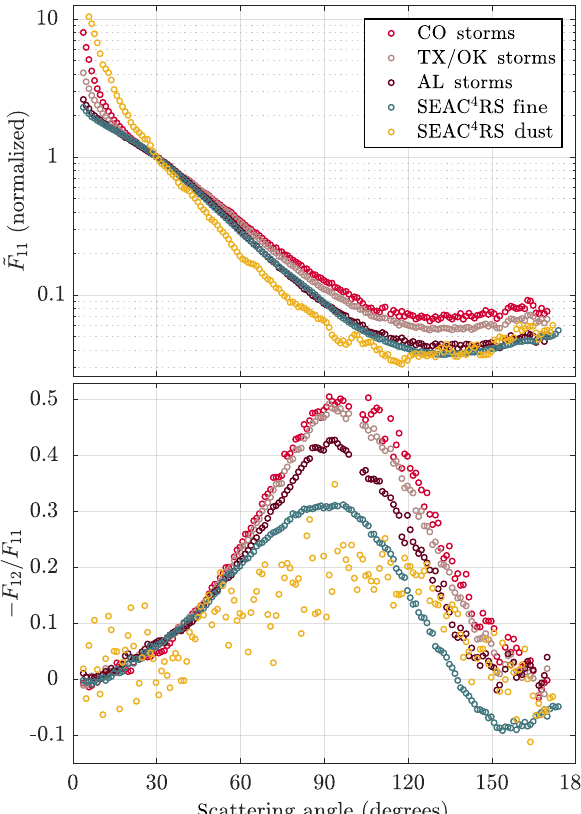
Figure 3. Average 532nm e F 11 and − F 12 /F 11 data for all three DC3 storm domains as well as dust and fine-mode-dominated aerosol types (biogenic, urban and BB) from SEAC 4 RS. Normal- ized phase function data are scaled such that e F 11 ( 30 ◦ ) =